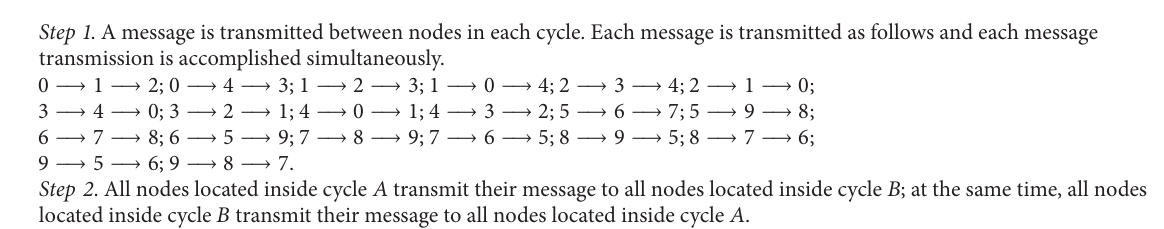
Algorithm 3: All-to-all broadcasting algorithm of Petersen graph under MLA